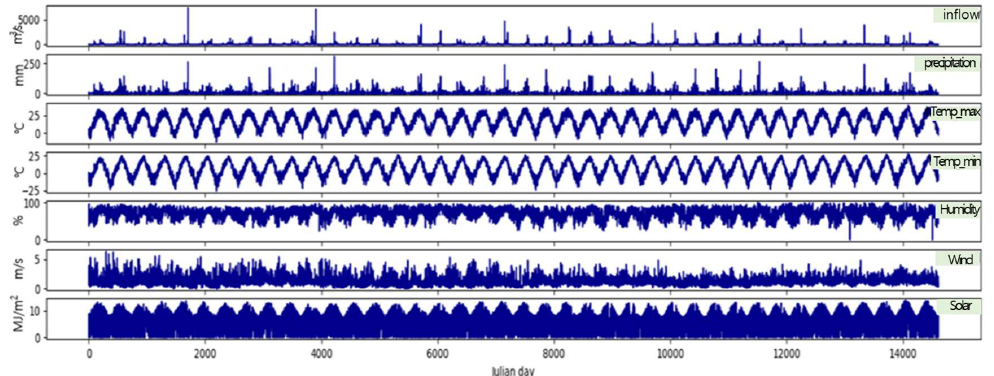
Figure 3. Time series variation of dam inflow and weather data.